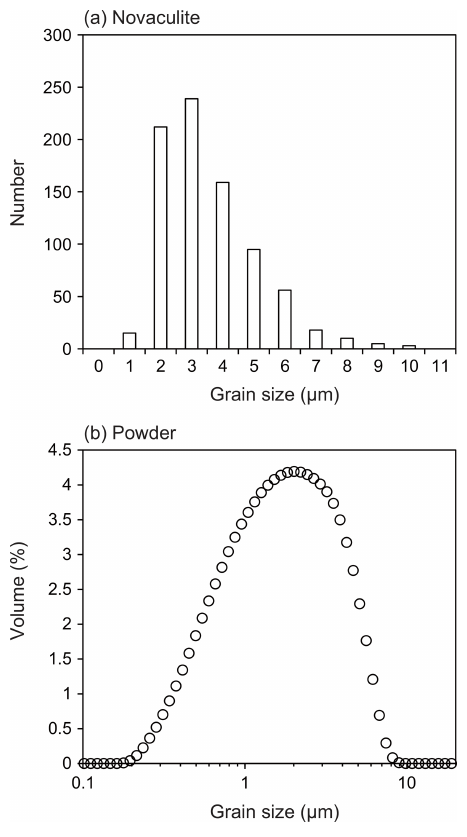
Figure 2. Grain size analyses of the starting samples. ( a ) Novaculite grain sizes obtained from grain outlines in EBSD band contrast im- ages. The average grain size is 3 . 1 ± 1 . 6µm (standard deviation). ( b ) Grain sizes of the quartz powder sample measured with a particle counter. The average grain size is 2 . 4 ± 1 . 7µm. These two average grain sizes were used as d 0 .